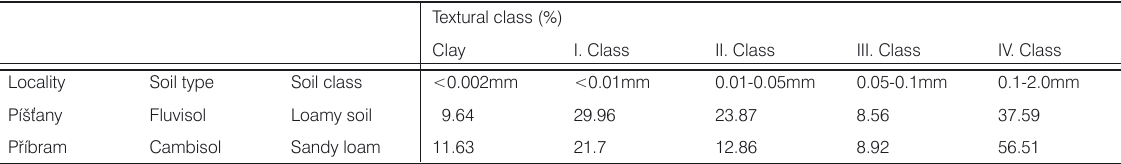
Table 2. Textural classes of investigated soils.